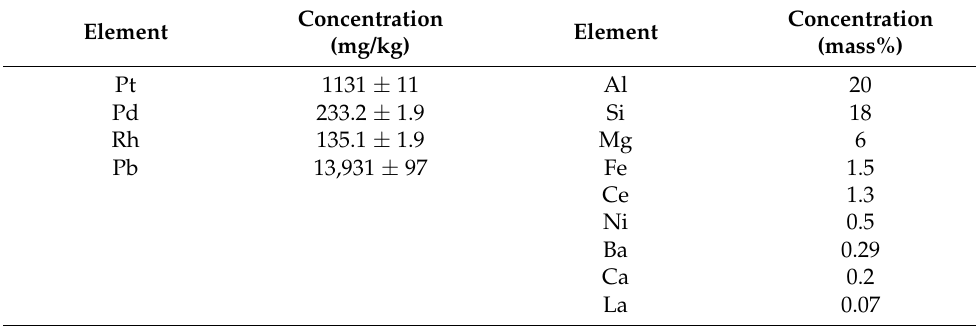
Table 1. Concentrations of elements present in the spent autocatalyst sample [29].